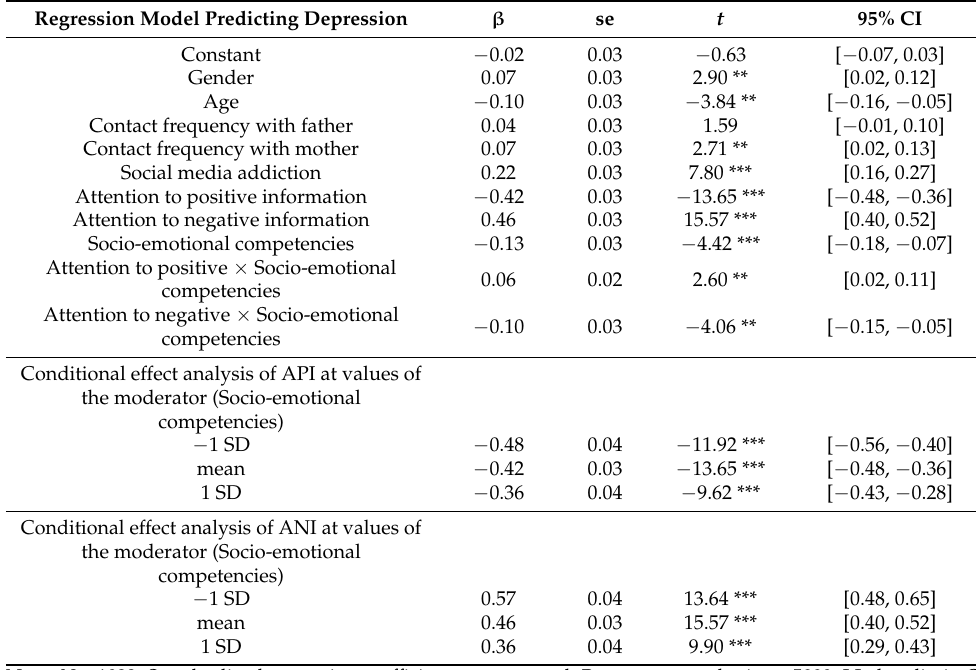
Table 5. Moderated mediation